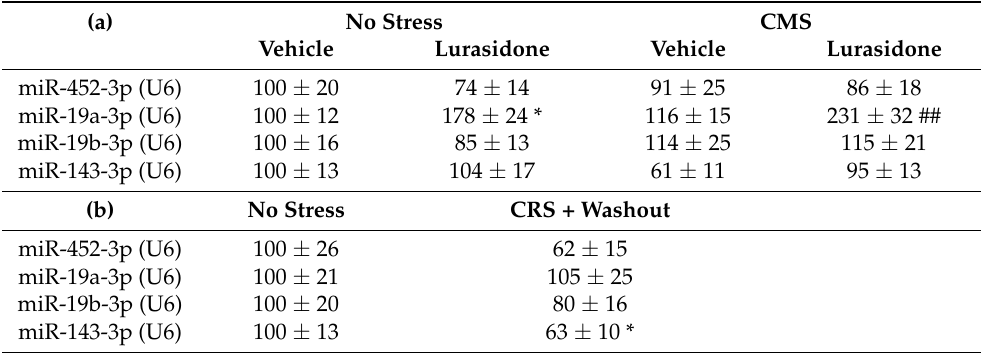
Table 1. ( a , b ): Analysis of miRNAs levels in chronically stressed rats treated with lurasidone ( a ) and after a period of washout from chronic stress exposure ( b ). The data, expressed as a percentage of no stress/VEH animals (set at 100%), are the mean ± SEM.U6 was used as internal controls. * p < 0.05 vs. No stress/VEH-No stress, ## p < 0.05 vs. CMS/VEH (Two-way ANOVA with Tukey multiple comparison’s